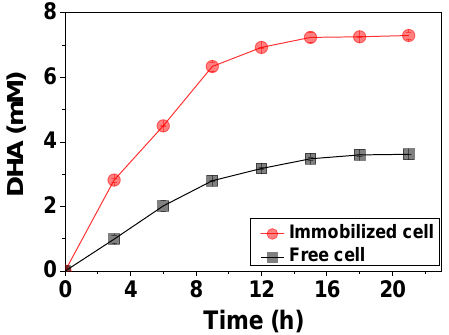
Figure 6. Time course of the synthesis 1,3-dihydroxyacetone (DHA) with immobilized cells. All the experiments were repeated three times, and the standard deviation was calculated and presented as error bars.